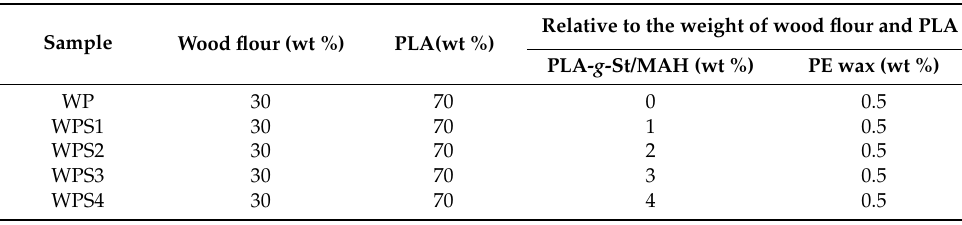
Table 1. Compositions of various wood flour/PLA